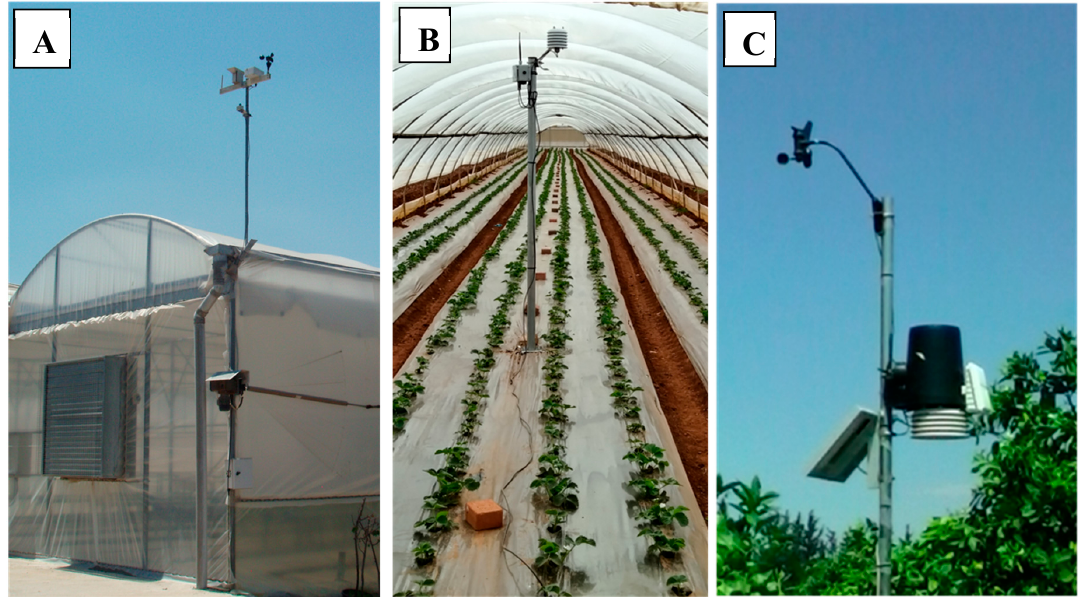
Figure 4. Meteorological station for monitoring weather data and calculating ETo; outside a high tech-greenhouse ( A ); inside a tunnel-type greenhouse ( B ); and in the field ( C ).